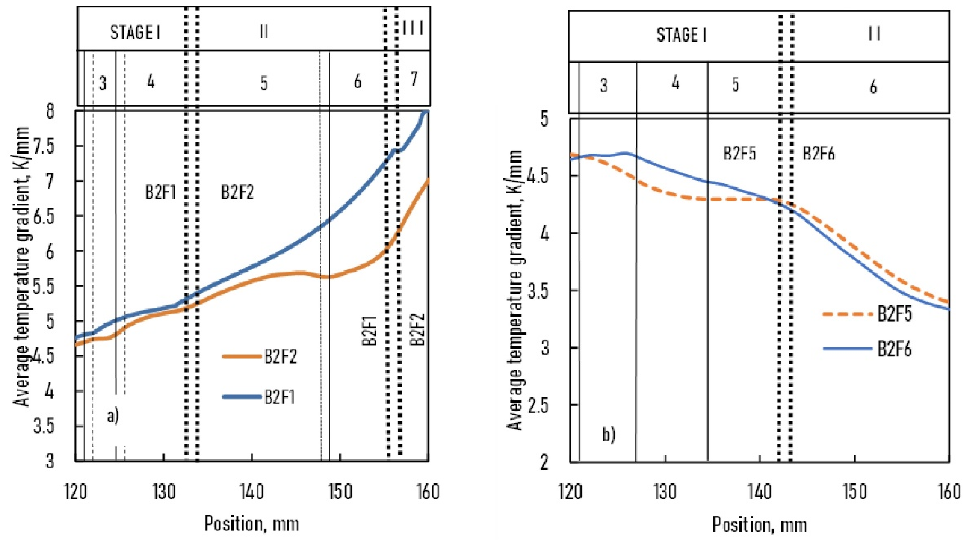
Figure 10 . Average temperature gradient of S/L and E/L fronts vs. position in the sample ( a ): samples B2F1 and BF2, ( b ): samples B2F5 and B2F6.